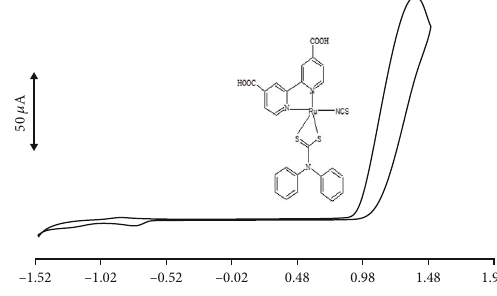
Figure 7: Cyclic voltammogram of FC